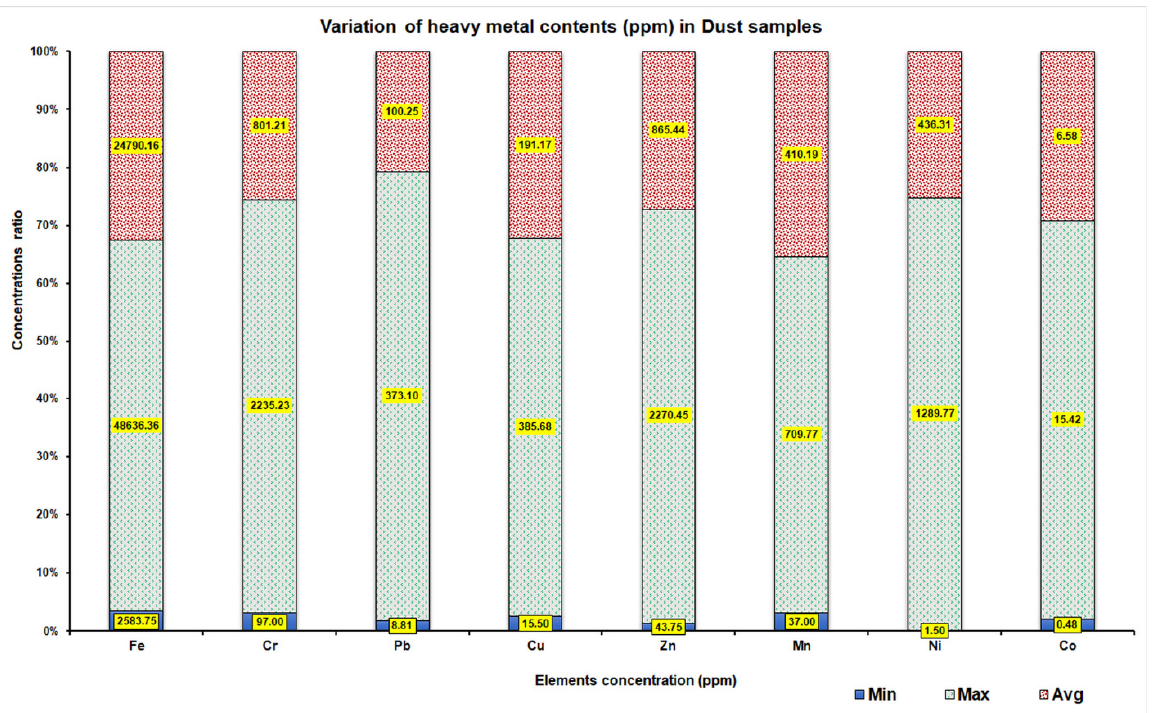
Figure 6. The variation of heavy metal concentration in the particulate samples in the study area.